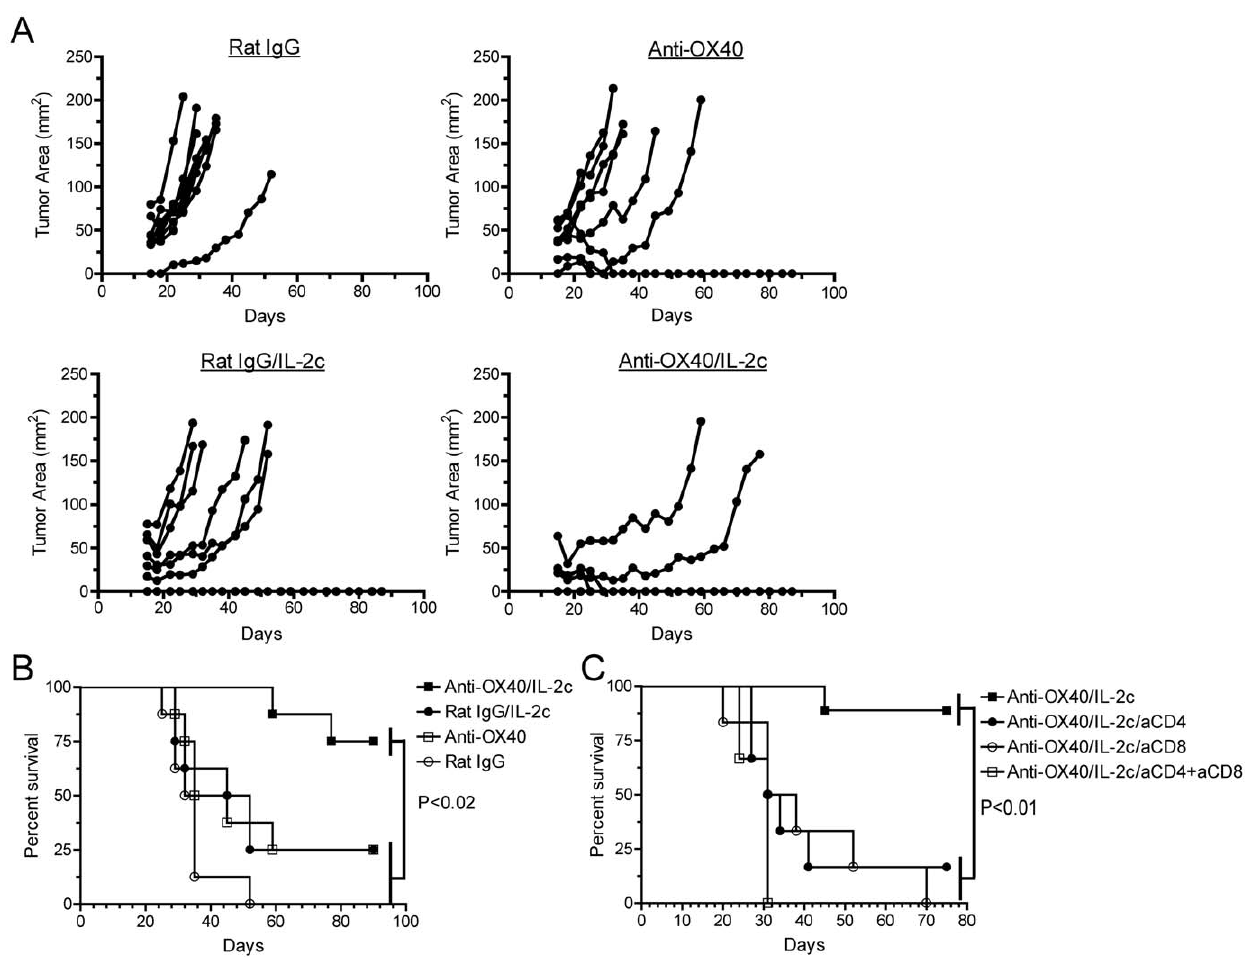
Figure 6. Combined anti-OX40/IL-2c therapy boosts anti-tumor immunity through a T cell-dependent mechanism. A, B ) Wild-type mice received 1 6 10 6 MCA-205 sarcoma tumor cells (n=8/group). Tumor-bearing mice were treated with anti-OX40 or rat IgG Ab (days 10, 14; i.p.) along with IL-2 cytokine/mAb complexes (days 10–13; i.p.) and the extent of A ) tumor growth and B ) survival of tumor-bearing mice were assessed. Data are representative of one out of 2 independent experiments. C ) MCA-205 tumor-bearing mice (as in ( A )) received no treatment (n=9), anti-CD4 (n=6), anti-CD8 (n=6), or anti-CD4 + anti-CD8 (n=3) (200 mcg/dose; i.p.) 9, 17, and 24 days post-tumor implantation. Mice were then treated with anti-OX40 (days 10, 14) and IL-2c (days 10–13) and the extent of survival of tumor-bearing mice was assessed.